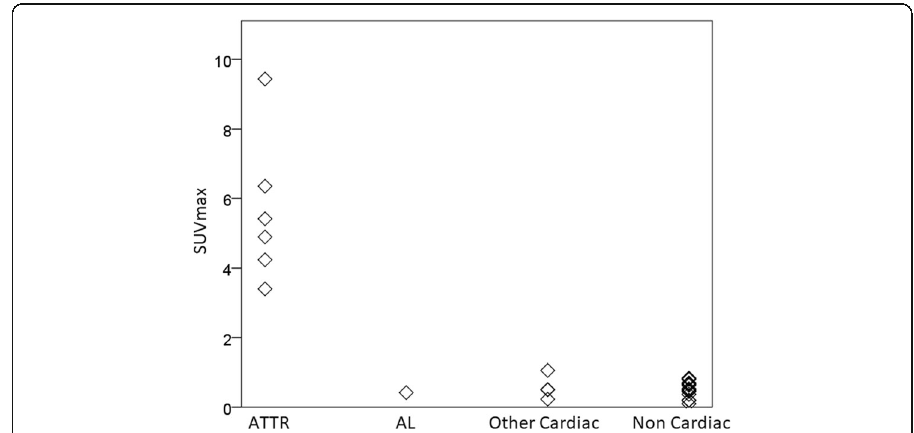
Fig. 4 Distribution of whole heart SUVmax measurements corrected for blood pool for subjects according to clinical